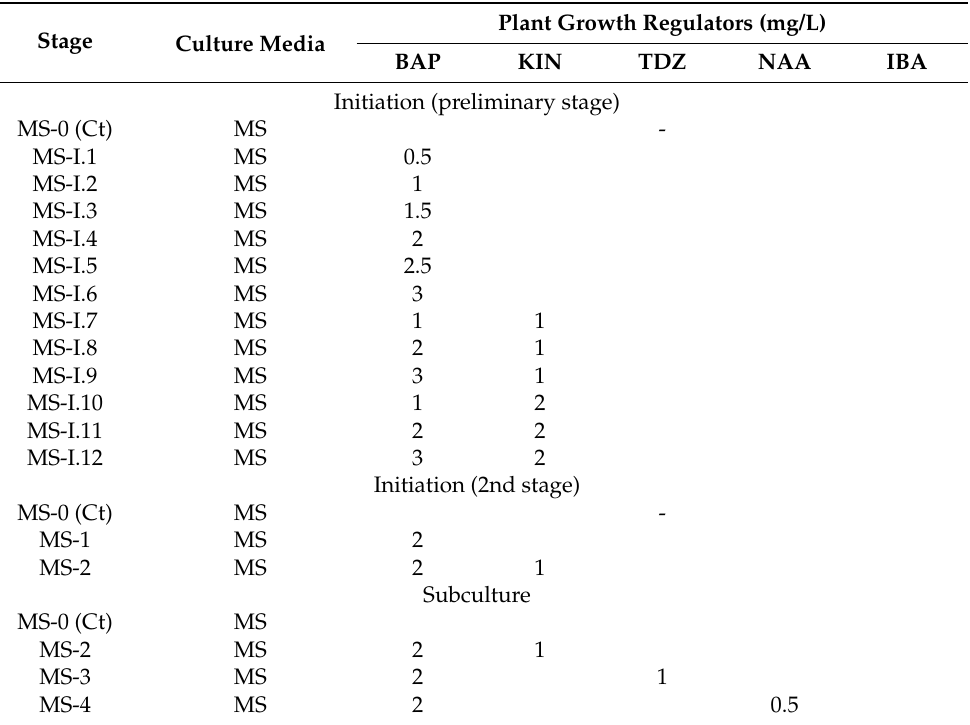
Table 1. Composition of culture media used for micropropagation of P. quadrangularis